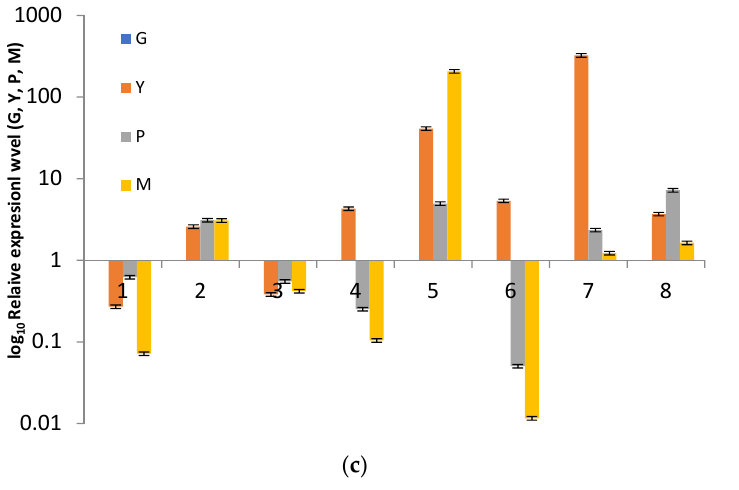
Figure 8. qRT-PCR detection of eight key differentially expressed genes. ( a ) Expression patterns of eight key genes involved in flavonoid biosynthesis. Each column represents the average value of three biological replicates, and the standard error is represented by vertical bars. ( b ) Pearson’s correlation analysis of the expression patterns of eight genes between qRT − PCR and RNA-seq data. Y: leaf; P: bark. ( c ) Relative expression level of the eight genes in different tissues. G: root; Y: leaf; P: bark, M: xylem. The numbers 1–8 on the abscissa axis in ( a , c ) indicate names of the eight genes